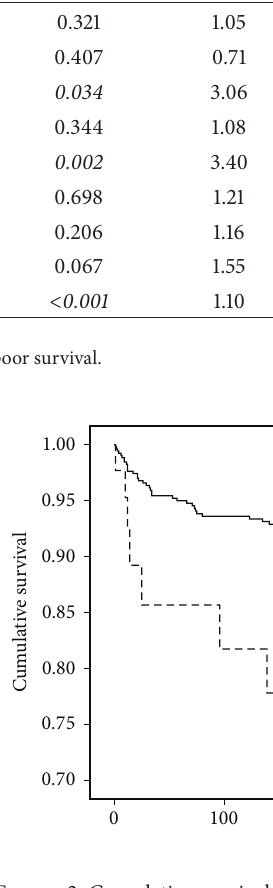
2.68; CI 1.14 to 6.03; 𝑃 = 0.024 ) in a binary regression analysis adjusted for age (OR 1.07; CI 1.04 to 1.12; 𝑃 < 0.001